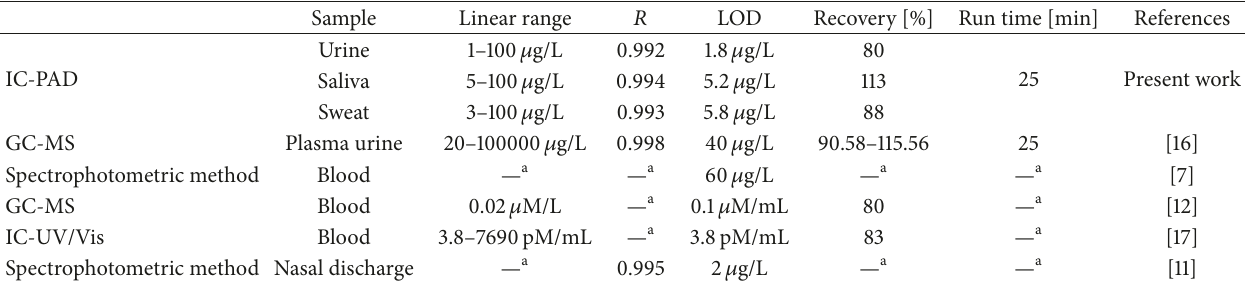
Table 3: Comparison of validation parameters for different methods of marking cyanides in biological materials